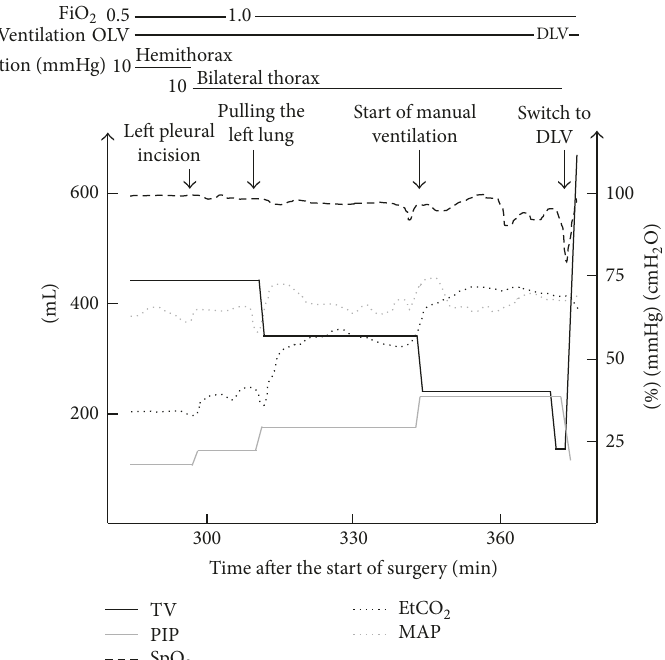
Figure 2: Changes of vital signs and ventilator settings in case 1. TV, tidal volume; PIP, peak inspiratory pressure; EtCO 2 , end-tidal carbon dioxide; MAP, mean arterial pressure; OLV, one-lung ventilation; DLV, double-lung ventilation.